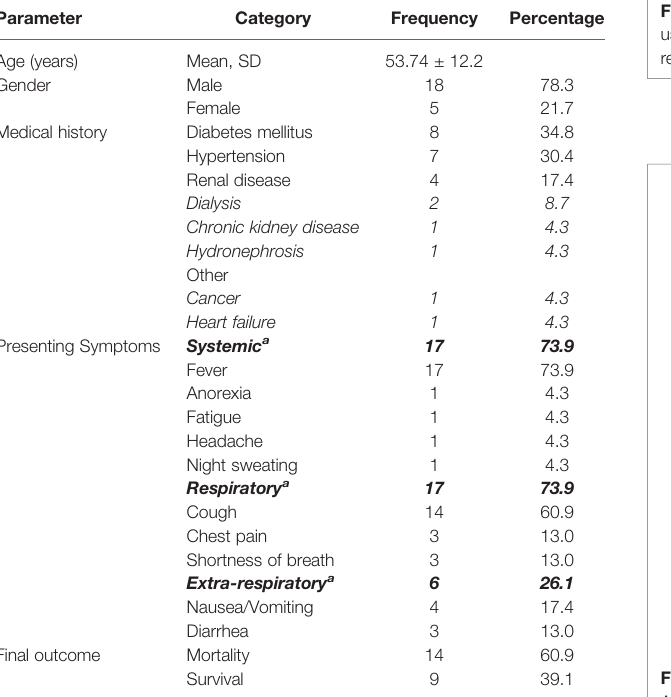
FIGURE 2 | Boxplot of the change in indices of qualitative IgG testing, using ABBOTT method, from the fi rst to second